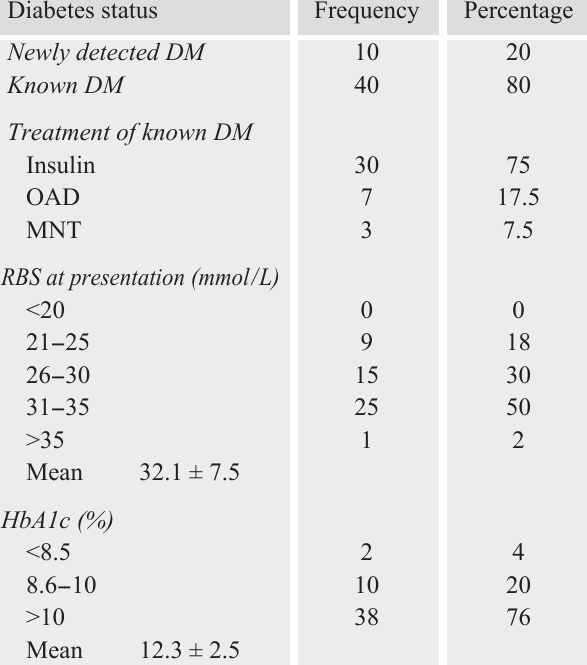
Table I: Status of DM of the study population (N=50) Diabetes